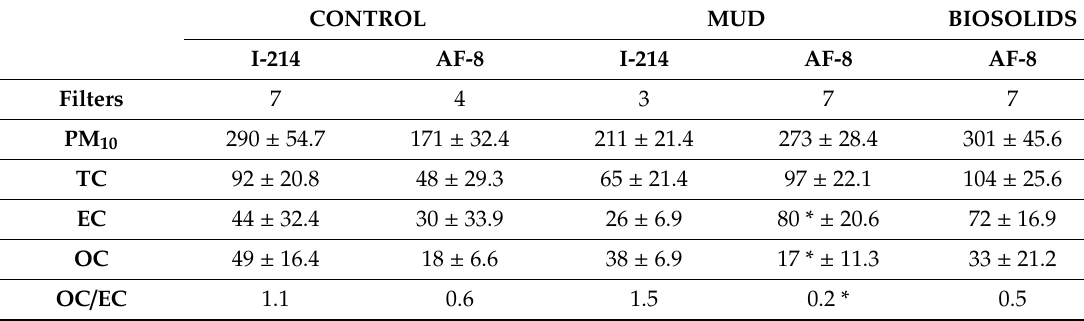
Table 4. Particulate matter emission factors (mg / MJ) from flue gases.